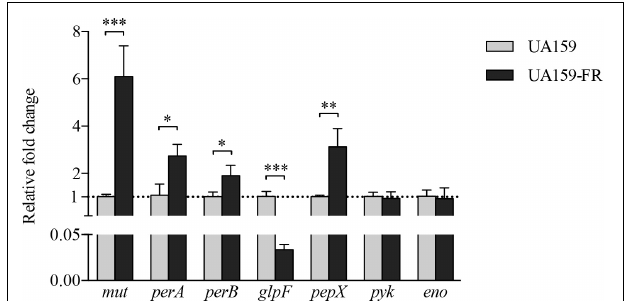
exponential phase are shown. Overall expression of each selected gene in UA159-FR relative to that in UA159 is presented as average fold change ± standard deviation. This experiment was repeated three times. All p- values were corrected for multiple testing. ∗ p < 0.05; ∗∗ p < 0.005; and ∗∗∗ p <